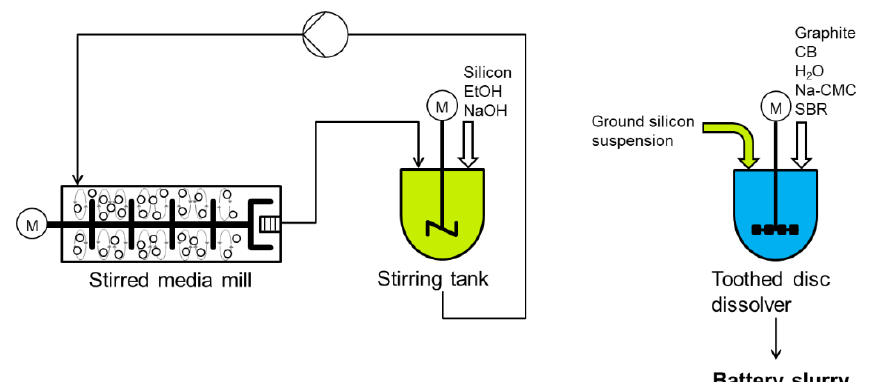
Figure 2. Setup for the production of a battery slurry by applying separate silicon grinding and dispersion of the other components.